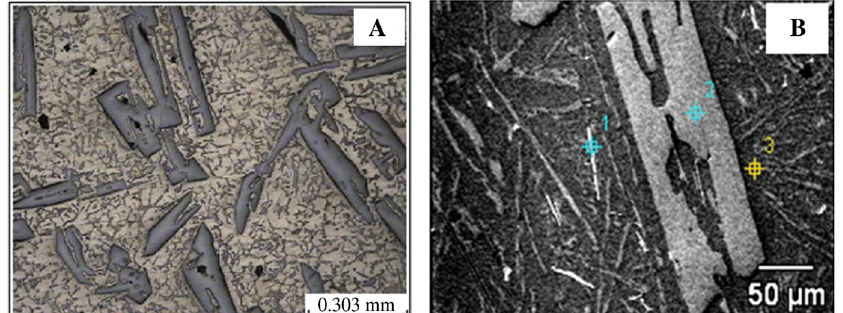
Figure 2: Microstructure of as-cast alloy (A) Optical and (B) SEM/EDS.